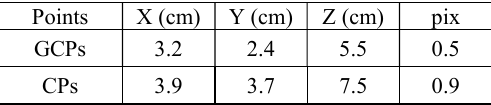
Table 2 . RMSE in X, Y, Z of GCPs and CPs.